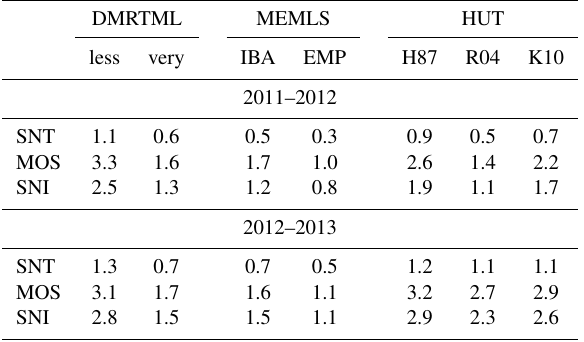
Table 7. Optimal microwave microstructure scale factors dependent on snow microstructure evolution function, based on minimisations of cost function between 1 November and 31 March in each year. Table 7 indicates scaling factors that would need to be applied to the grain diameter in order to allow a particular DMRTML MEMLS HUT microstructure evolution function to minimise the CF given in Eq. (16), i.e. the best agreement with observed brightness temperature for all four frequency and polarisation combi- nations. A scale factor of 1 suggests a perfect fit between snowpack microstructure and microwave microstructure. A scale factor of less than 1 indicates a snowpack grain diam- eter overestimate, whereas a scale factor of greater than 1 is an underestimate. For SNT microstructure, a scale factor of less than 1 was required in 2011–2012 for all emission mod- els with the exception of the less sticky ( τ = 0 . 2) applica- tion of DMRT-ML. This indicates that the SNT microstruc- ture resulted in grain diameters larger than that required by the emission models for that year. In 2012–2013 SNT mi- crostructure required slight scaling to increase the grain di- ameter for HUT and for less sticky DMRT-ML, but down- scaling for very sticky hard spheres in DMRT-ML and